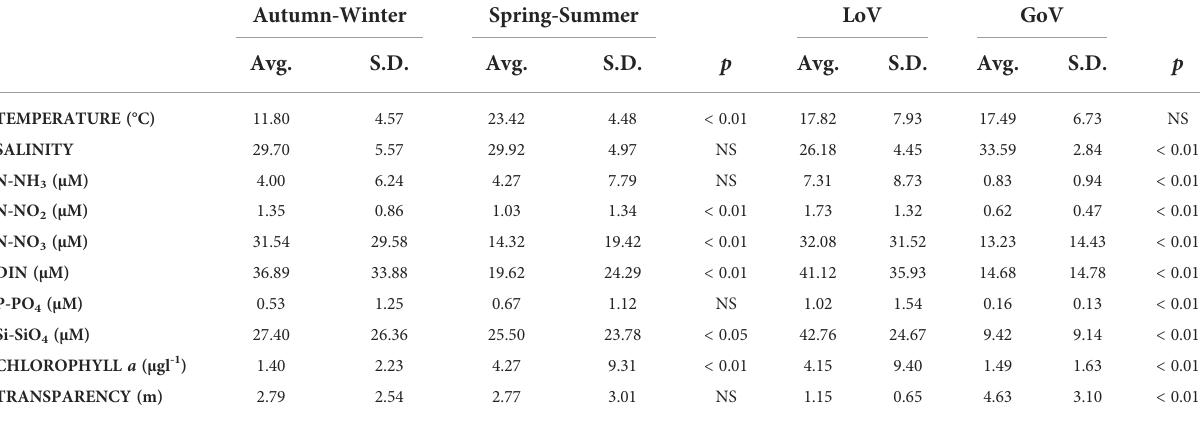
TABLE 2 Results of the ANOVA performed on the groups (seasons and stations) highlighted by the PCA. Avg, average values; S.D, standard deviations; p, probability; DIN, Dissolved Inorganic